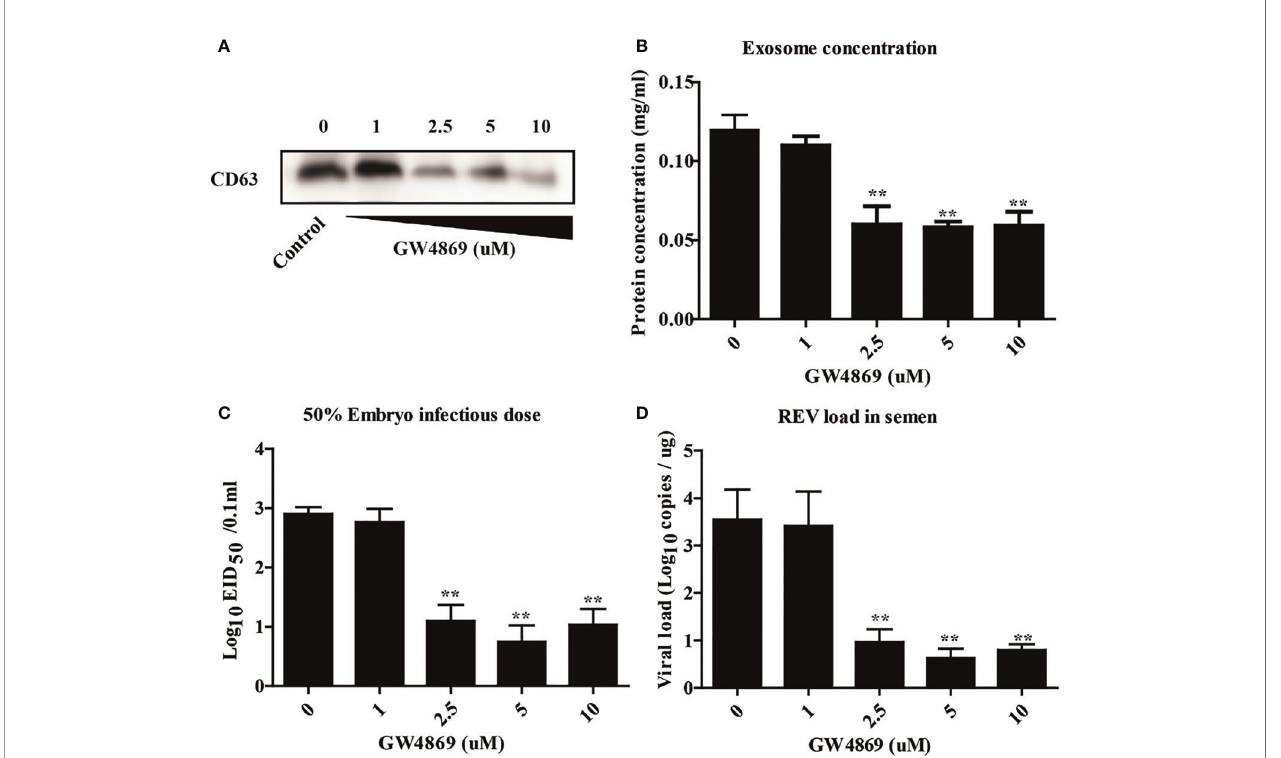
FIGURE 3 | Inhibition of exosome release decreased the viral load of REV in semen. (A) The isolated exosomes from cocks treated with GW4869 in different doses were subjected to Western blotting analysis of CD63 expression. (B) Protein concentration analysis using the BCA kit. (C) The viral titers were determined with the EID 50 assay. (D) Quantitative RT-PCR was performed to detect REV viral load in isolated exosomes. **Indicates signi fi cant difference ( p < 0.01) between the two experimental